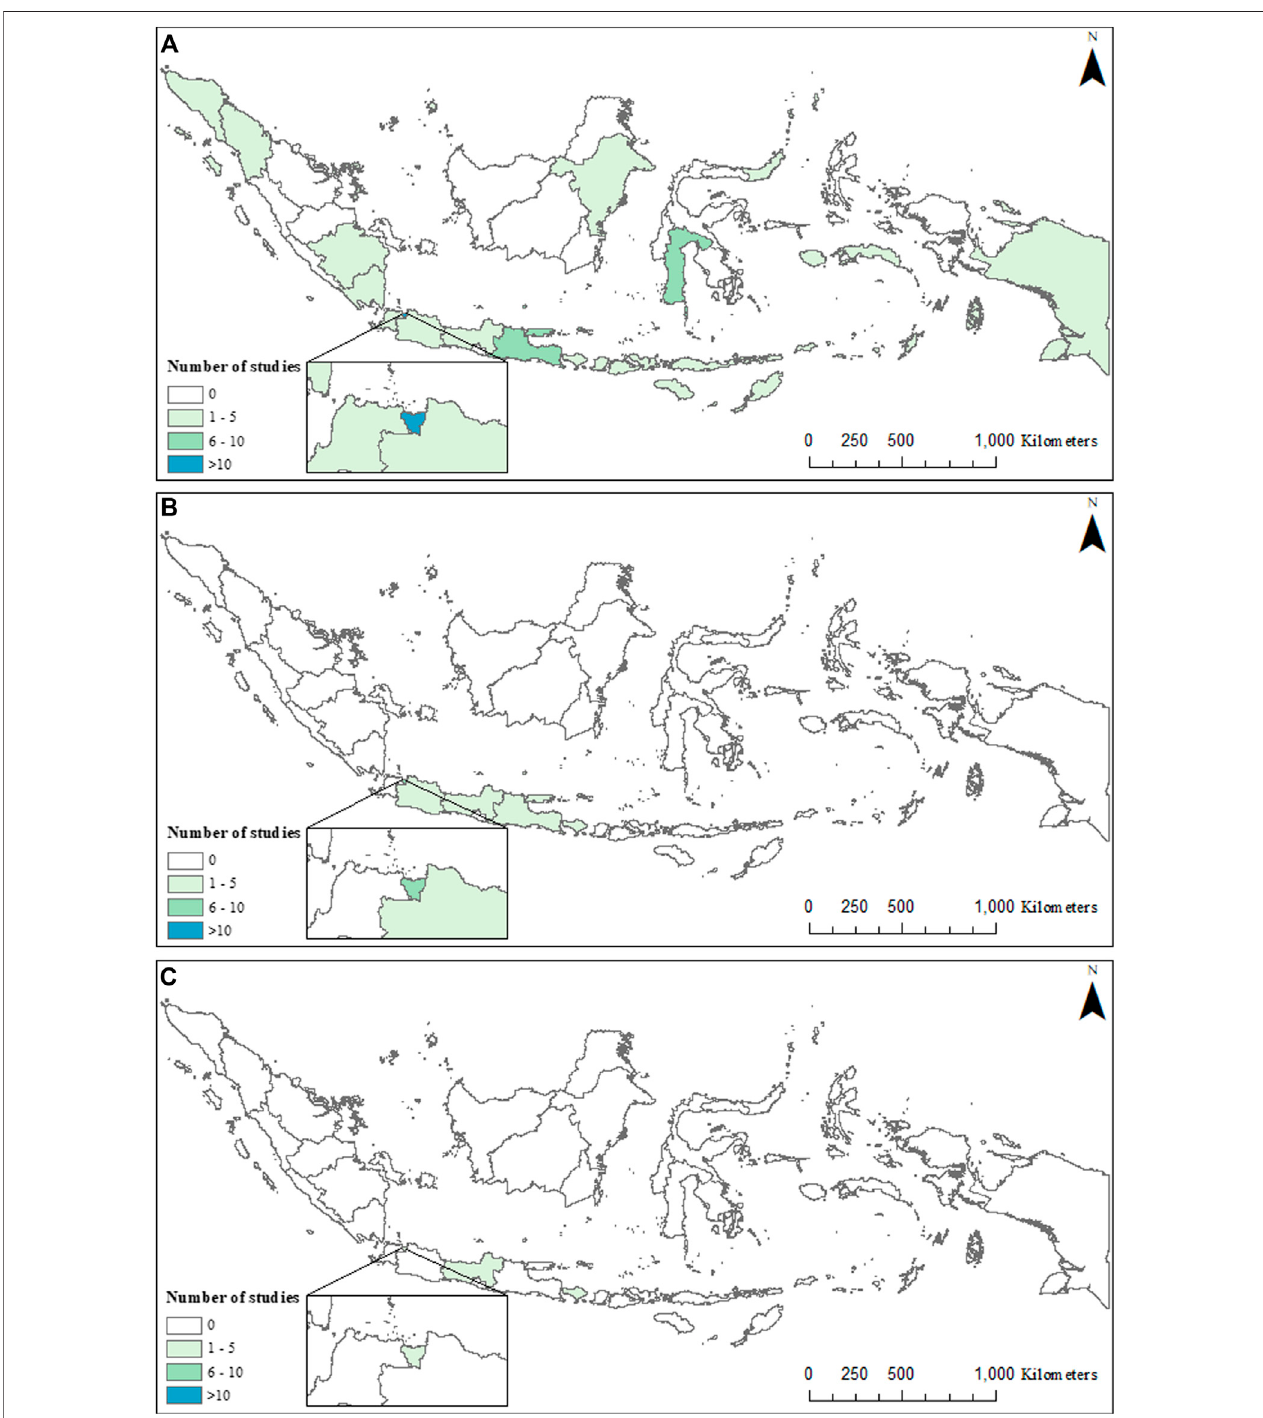
FIGURE2| Numberofplastic pollutionstudies performedinIndonesiaaggregated tosub-regions,where (A) .depictsmarine focusedliterature (landmassclosest to research area), (B) . depicts studies focused on rivers literature, and (C) . represents land focused research.